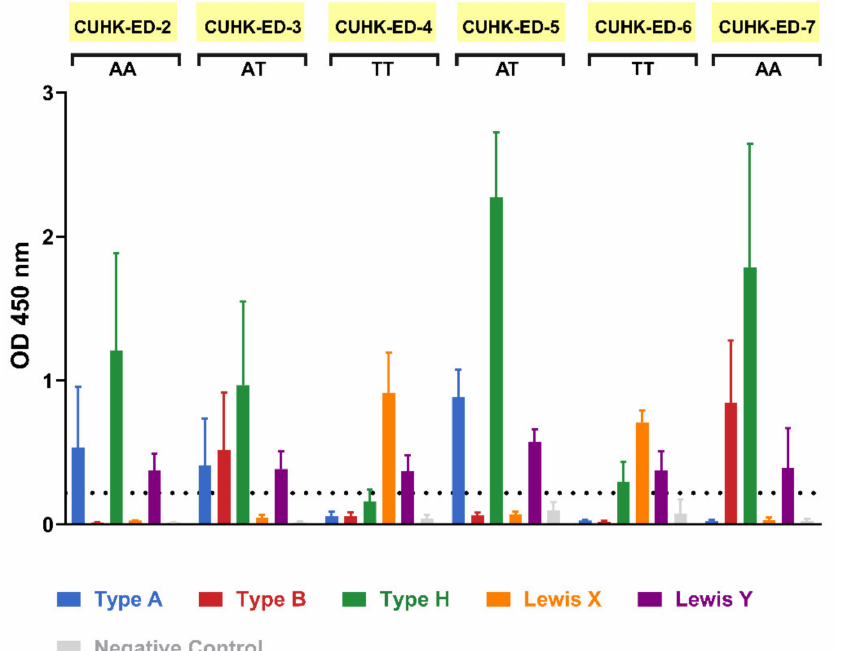
Figure 1. Secretor status phenotyping of enteroid donors obtained via an enzyme-linked immunosor- bent assay (ELISA)-based method: saliva phenotyping was performed as three independent experi- ments. FUT2 A385T genotype status is shown below each sample name, where AA and AT refer to secretor positive and TT refers to weak secretor. For the negative control, HBGA-specific primary antibodies were replaced with one of the followings: diluent (for CUHK-ED-2, CUHK-ED-3 and ED-4), IgG isotype control (for ED-5) and IgM isotype control (for ED-6 and onwards). The horizontal dotted line represents an optical density (OD) absorbance of 0.2 at 450 nm. Error bars represent the standard deviation of the mean of the three technical